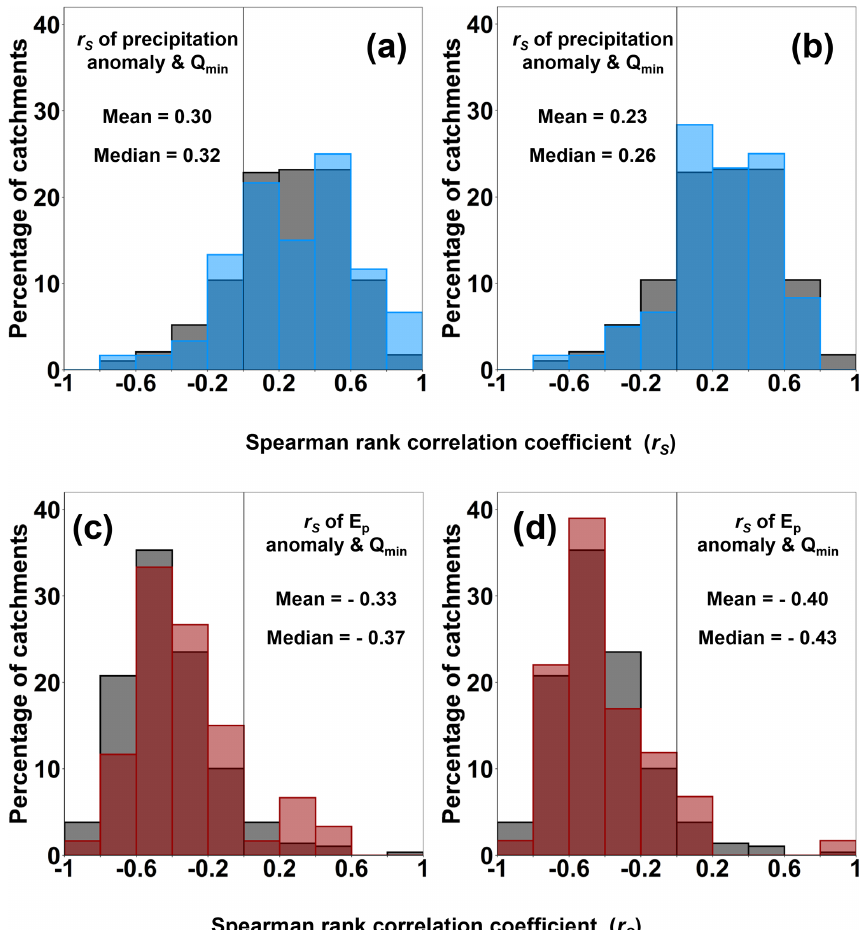
Figure 9. Histograms of rank correlations between low-flow magnitudes and anomalies of precipitation (a, b) and potential evapotranspira- tion (c, d) for warm-season low flows across Swiss catchments. The left side (a, c) shows the distributions for the 20% of catchments with the least human impact (blue and red) on top of the distributions for all data (gray). The right side (b, d) shows the distributions for the 20% of catchments with the most human impact (blue and red), again plotted on top of the distributions for all data (gray). The observed distributions of correlations between the 30d climate anomalies and the magnitudes of low flows are similar in catchments with the most and the least human